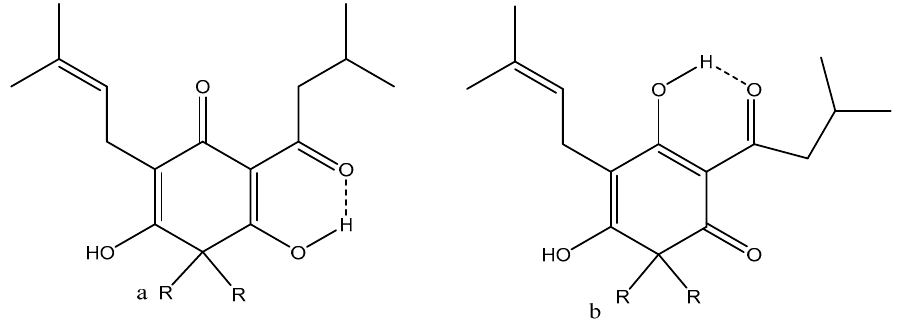
Figure 9. Lupulone, R is equal to isoprene. ( a ) and ( b ) are different positional enol isomers.